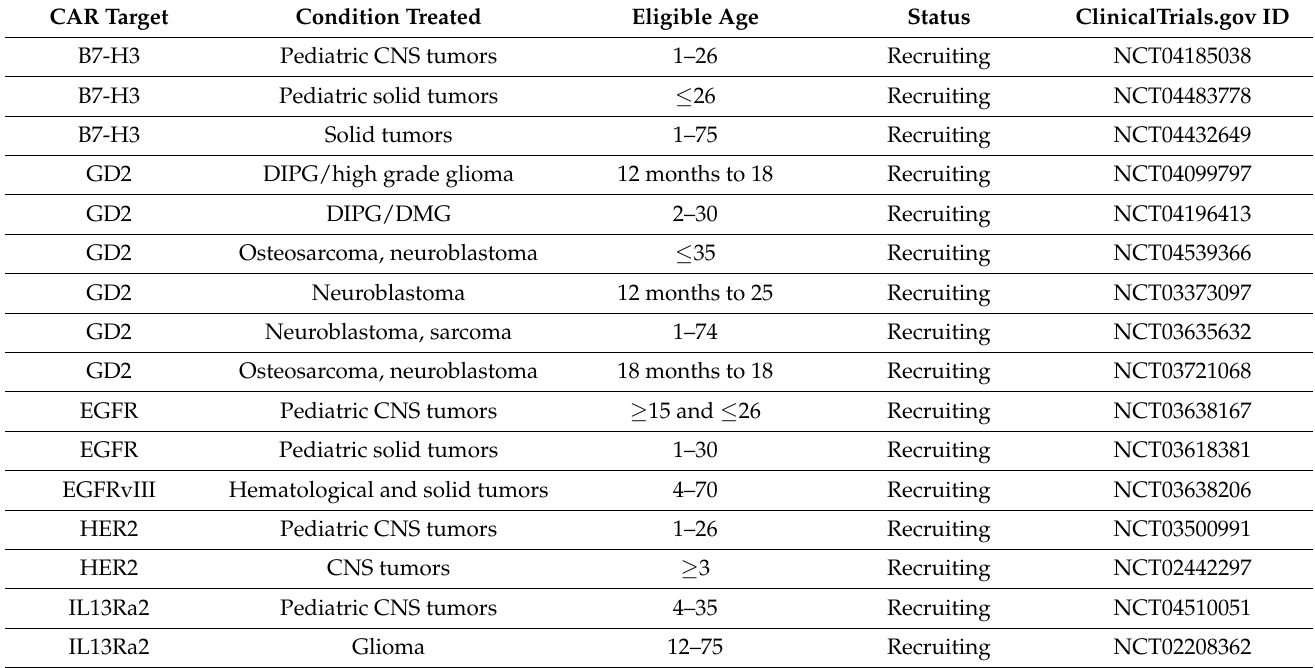
Table 3. CAR T cell trials for pediatric solid